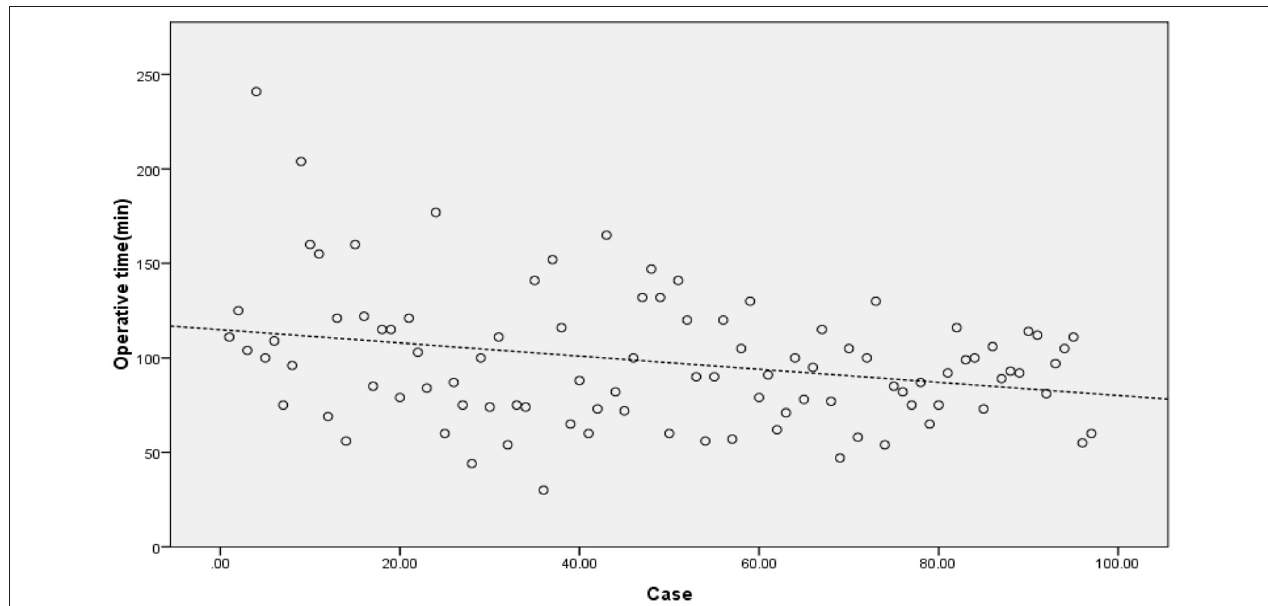
FIGURE 2 | The scatter chart of the operation time showed a downward trend. The dashed line was automatically linear fitted by SPSS software.